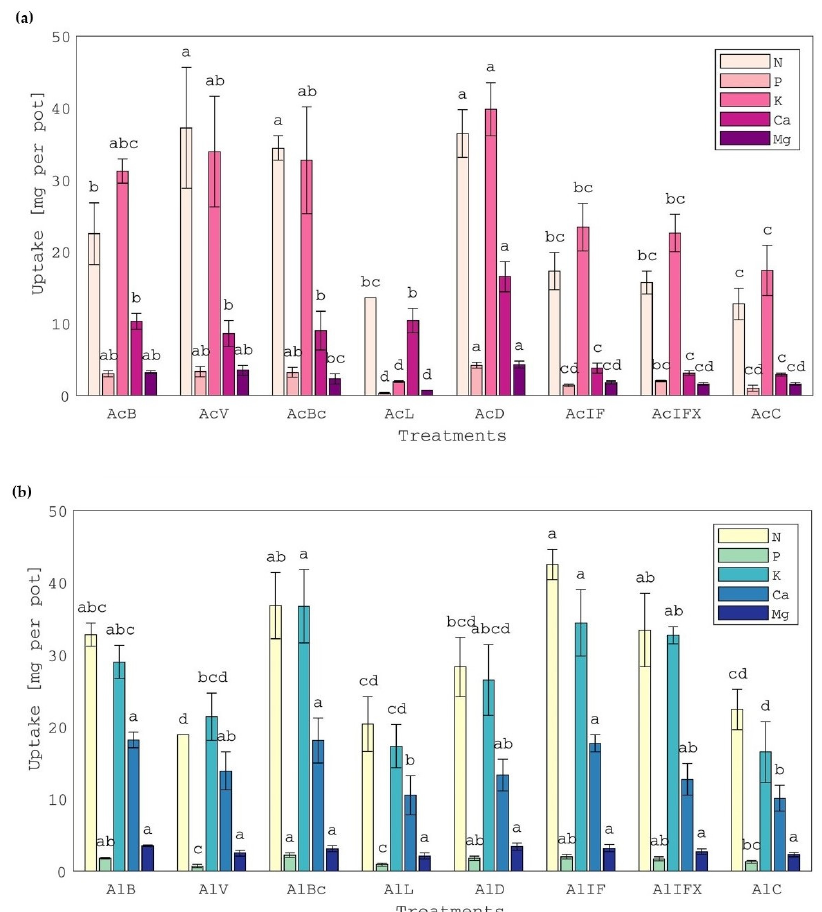
Figure 2. Uptake of macronutrients by white clover plants, grown in ( a ) acid soil treatments and ( b ) alkaline soil treatments. Treatment of the acid and alkaline soil, respectively, with: AcB and AlB: bentonite-treated sludge; AcV and AlV: vermiculite-treated sludge; AcBc and AlBc: biochar-treated sludge; AcL and AlL: limed sludge; AcD and AlD: air-dried sludge; AcIF and AlIF: N-P-K inorganic fertilization; AcIFX and AlIFX: P-K inorganic fertilization; AcC and AlC: control. Different letters, within each soil and property, indicate significant differences among means, using the LSD test, at p ≤ 0.05.